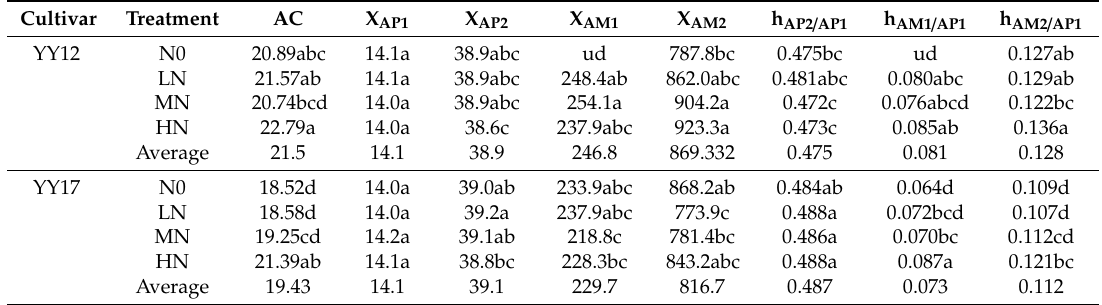
Table 3. Starch molecular parameters extracted from size exclusion